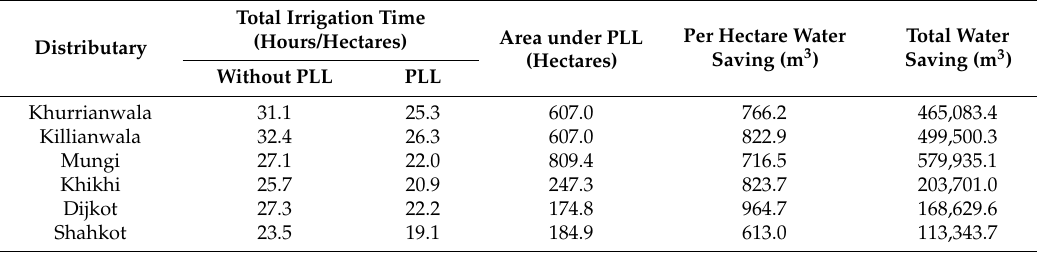
Table 2. Water savings from wheat under PLL.